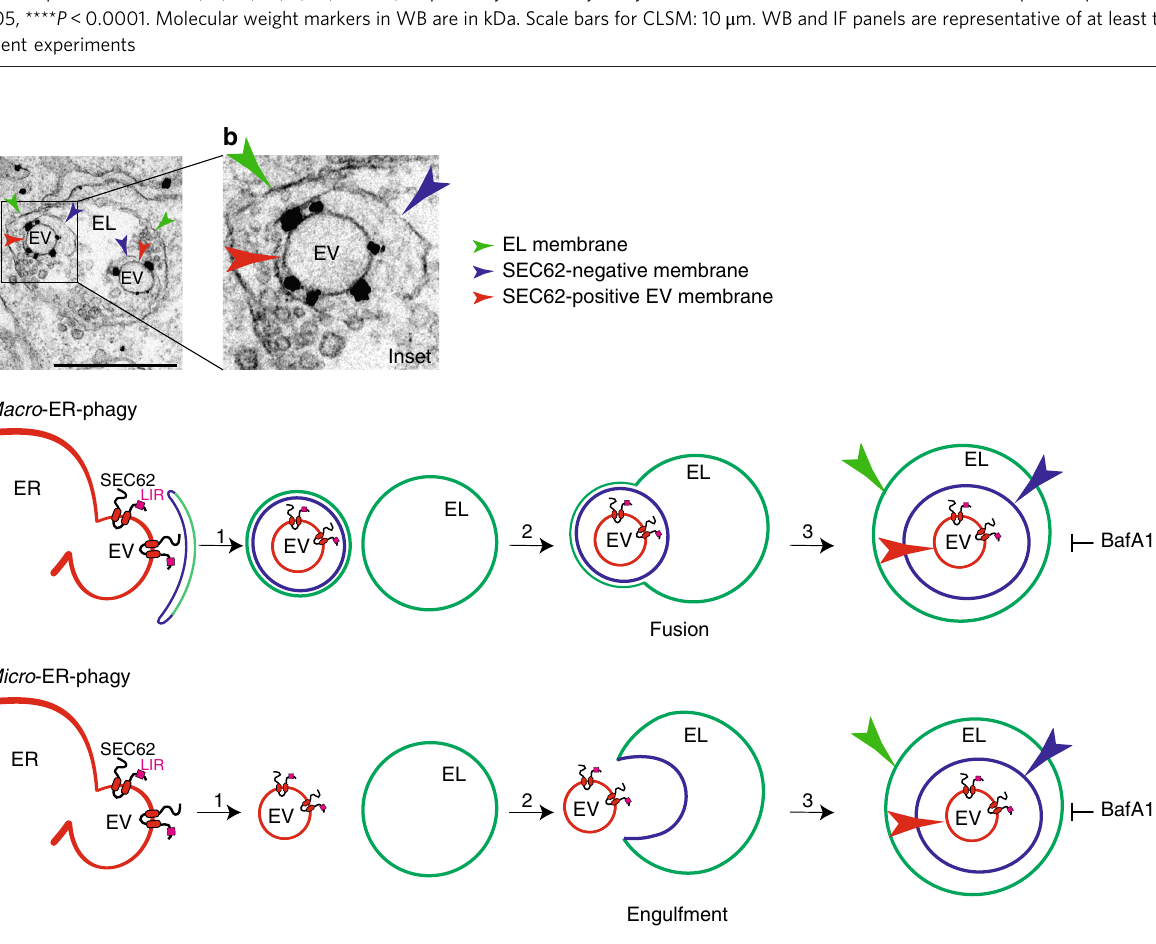
Fig. 1 Delivery of endogenous SEC62-labeled EV within EL during recovery from ER stress. a Upper panel, WB analysis showing steady-state level of BiP in